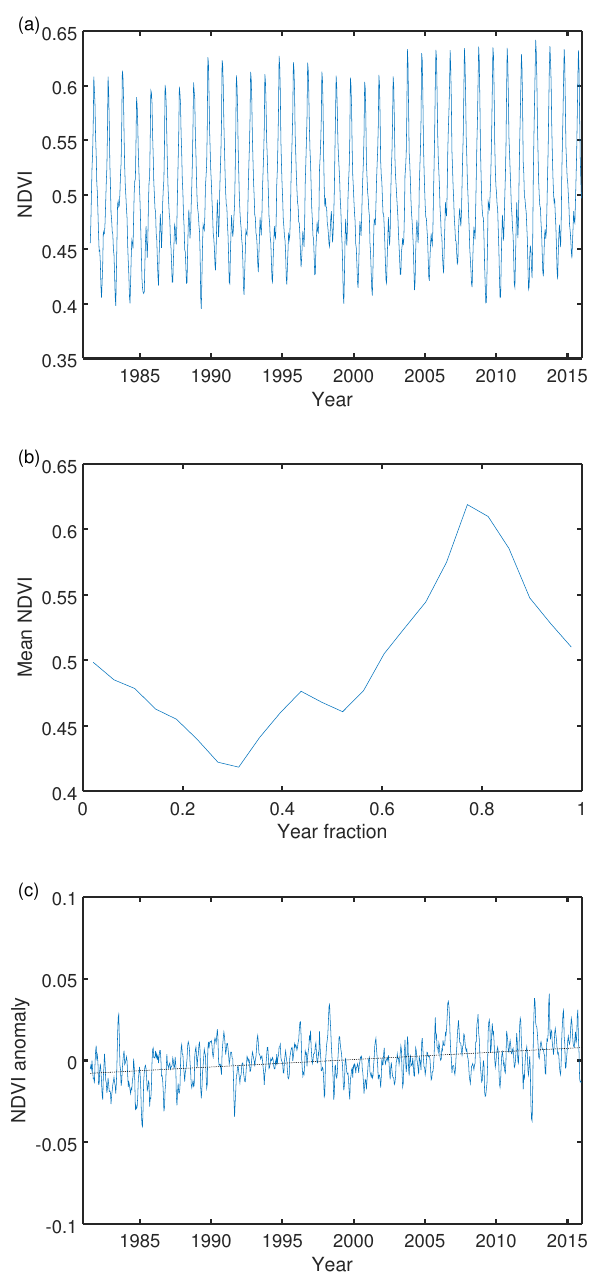
Figure 7. The same as Figure 5, but using mean normalized difference vegetation index (NDVI) as predicted by the random forest regression